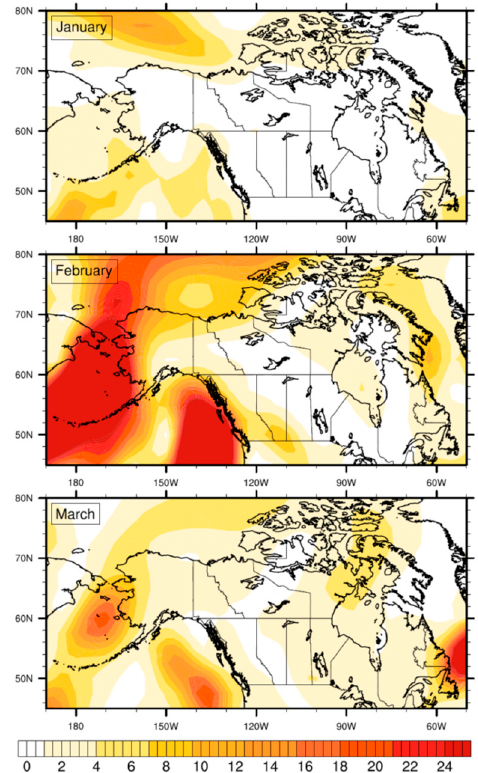
Figure 5. Sea level pressure (hPa) in ( a ) 1–15 January; ( b ) 16–31 January; ( c ) 1–14 February; ( d ) 15–28 February; ( e ) 1–11 March 2019.